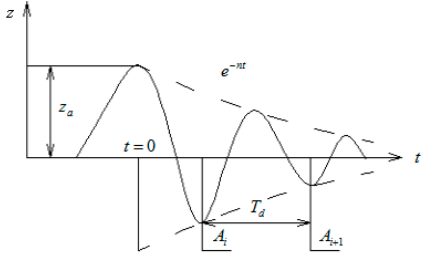
Figure 5. Diagram of free-decay oscillatio n.